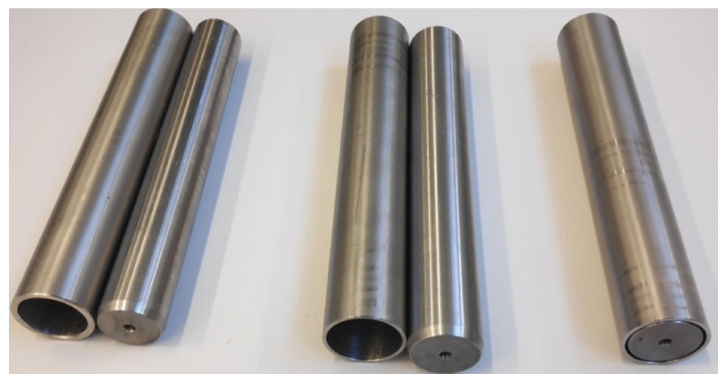
Figure 4. Billets consisting of a sleeve and a core prepared for the rolling